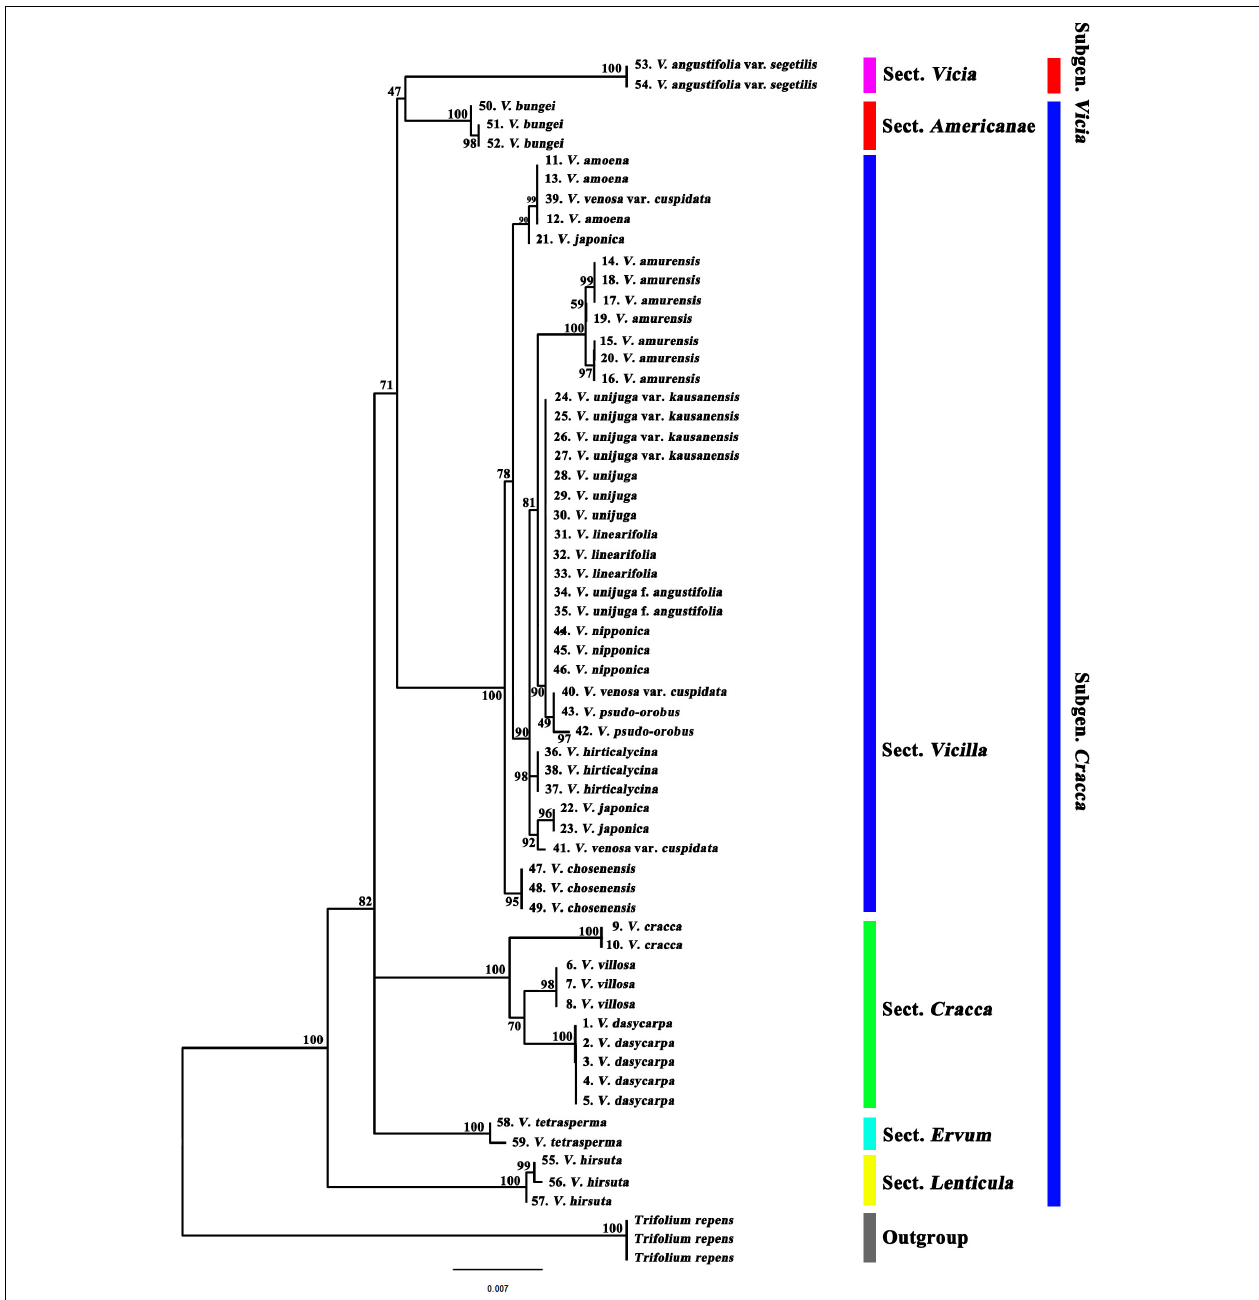
FIGURE 2 | Phylogenetic analysis of 19 Vicia species based on the nucleotide sequences of the combined ITS2 + matK + rbcL